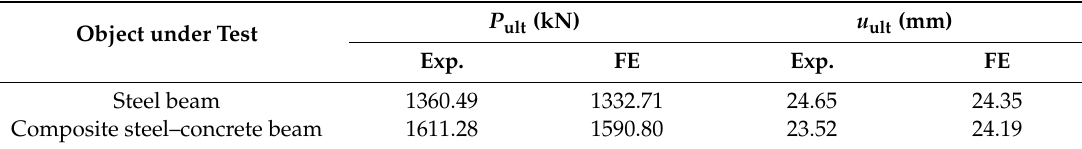
Table 3. Comparison of the determined ultimate values: P ult and u ult .